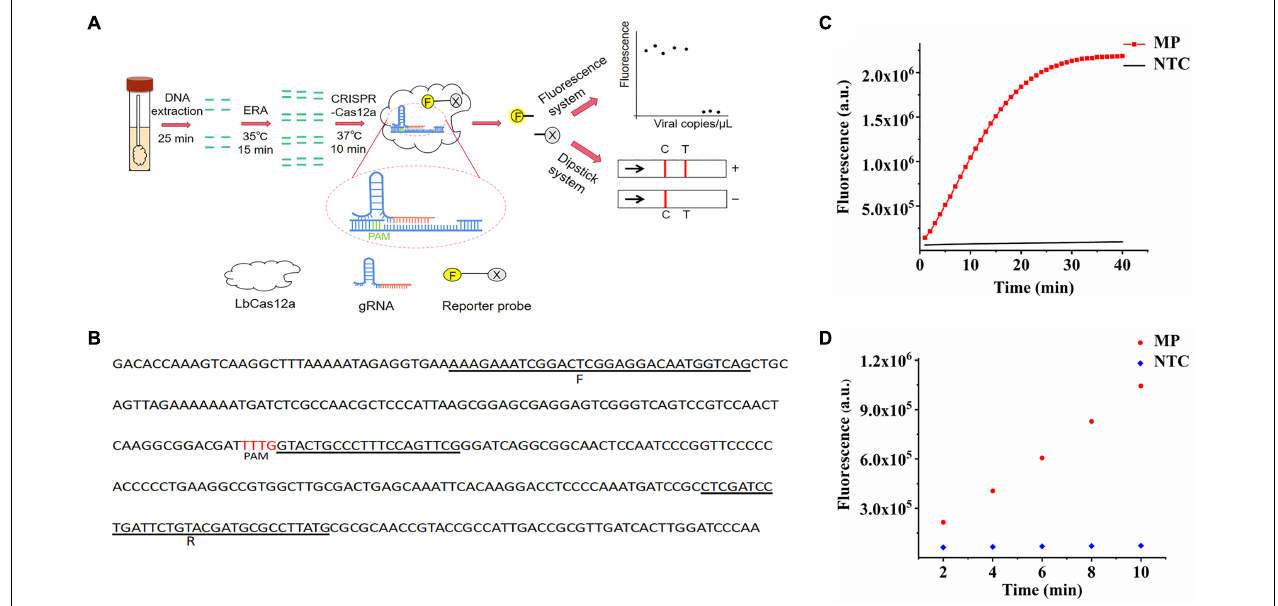
FIGURE 1 | Feasibility of the ERA/CRISPR–Cas12a system. (A) ERA/CRISPR Cas12a dual-system framework. The DNA of M. pneumoniae samples was extracted within 25 minutes, and the target sequence was amplified by ERA (15 minutes). The LbCas12a-gRNA complex recognized the amplification product and triggered the “collateral cleavage” activity, which cleaved ssDNA reporters (15–20 min). Qualitative analysis can be carried out by observing the fluorescence signal or chromatographic dipstick. T: test line; C: control line. (B) The selected sequence was the target fragment of the M. pneumoniae adhesion P1 sequence in this study. F was the forward primer of the ERA/CRISPR–Cas12a dual system, R was the reverse primer, PAM was the protospacer adjacent motif of the CRISPR array, and the immediately followed scribed fragment was the reverse complementary fragment of gRNA, which was the target sequence. (C) Real-time detection of Cas12a trans-cleavage activity using an F-Q reporter. NTC: no-template control. (D) M. pneumoniae fluorescence intensity compared with NTC within 10 min of reaction.